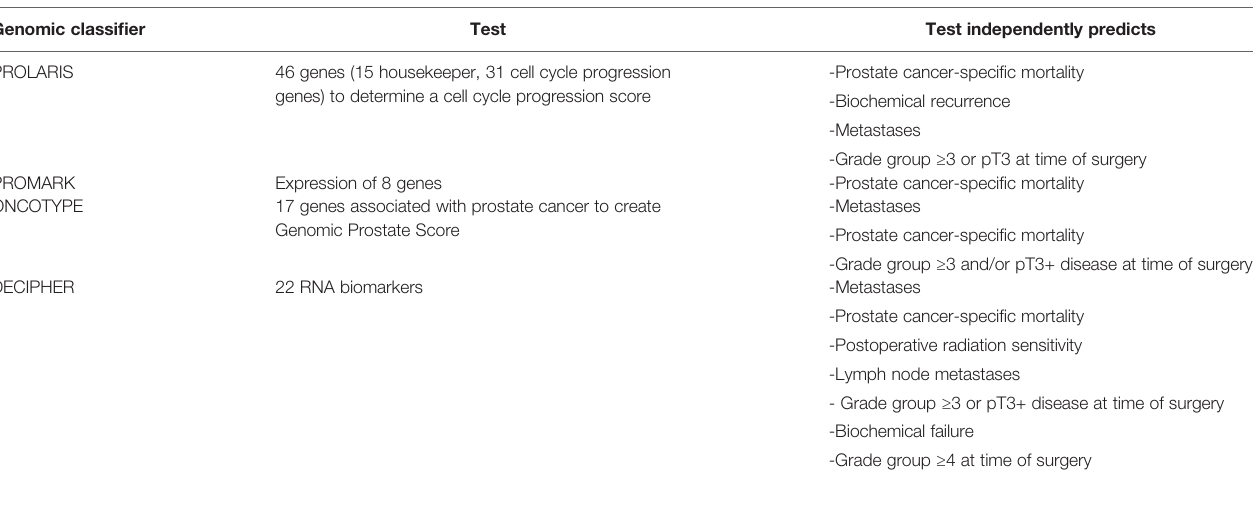
TABLE 3 | Molecular tests for Prostate Cancer Risk Strati fi cation.